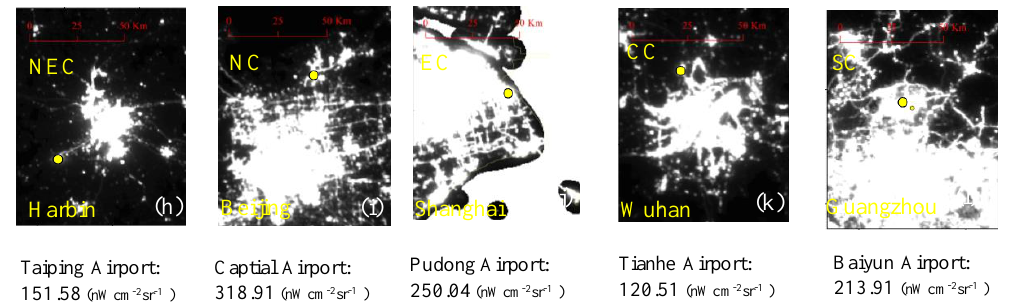
Figure 3. The original National Polar-Orbiting Partnership’s Visible Infrared Imaging Radiometer Suite (NPP-VIIRS) data in 2012. (a) outliers in Daqing, Heilongjiang; (b) outliers in Aksu, Xinjiang. (c) the airport in Urumqi; (d) the airport in Hohhot; (e) the airport in Xian; (f) the airport in Chengdu; (g) the airport in Lhasa; (h) the airport in Harbin; (i) the airport in Beijing; (j) the airport in Shanghai; (k) the airport in Wuhan; (l) the airport in Guangzhou.